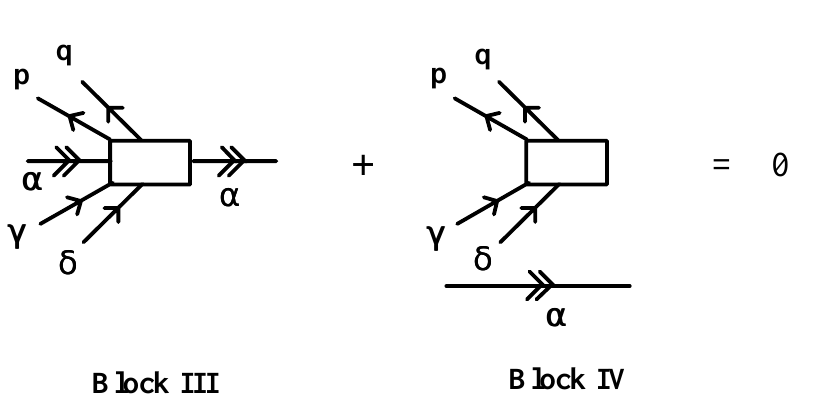
Figure 5: Block equation for pseudo-three-body operators: Block III contains the pseudo-three- body operators with spectator scattering, whereas Block IV contains closed-shell two-body oper-